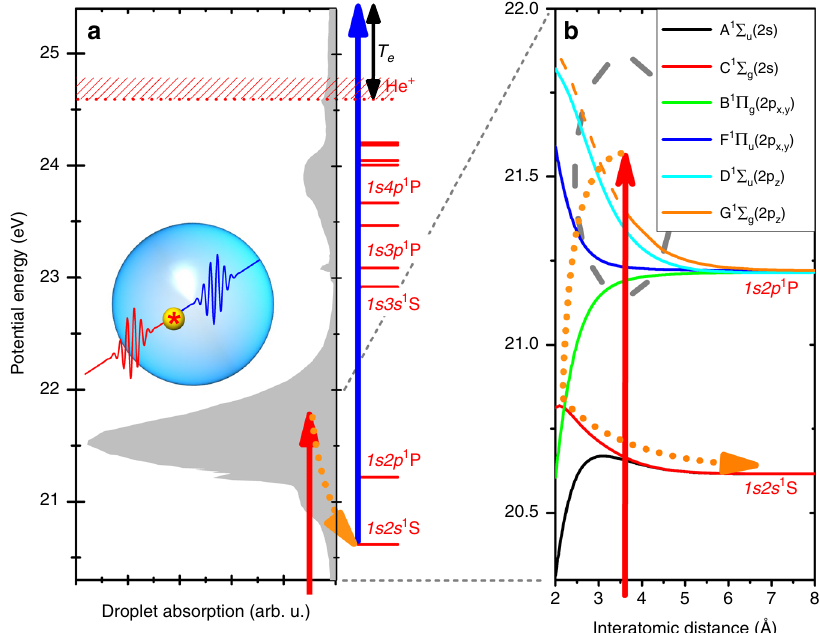
Fig. 1 Illustration of the pump-probe scheme. a The fi lled area represents the absorption spectrum of He nanodroplets taken from Joppien et al. 18 . He atomic levels are shown on the right-hand side. b Potential curves of the singlet-excited He (cid:1) were computed as detailed in the Methods section. The vertical straight arrows indicate the pump and probe laser pulses, the dotted curved arrows indicate the droplet relaxation pathway. The double-sided arrow in ( a ) illustrates the electron kinetic energy T